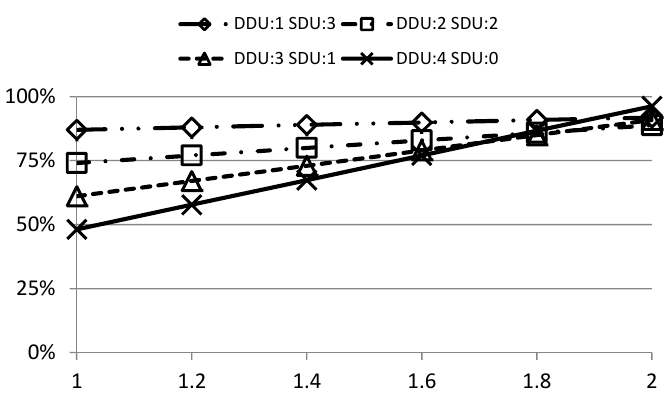
Figure 9. Sensitivity to dynamic power of DDU (50%-scenario).